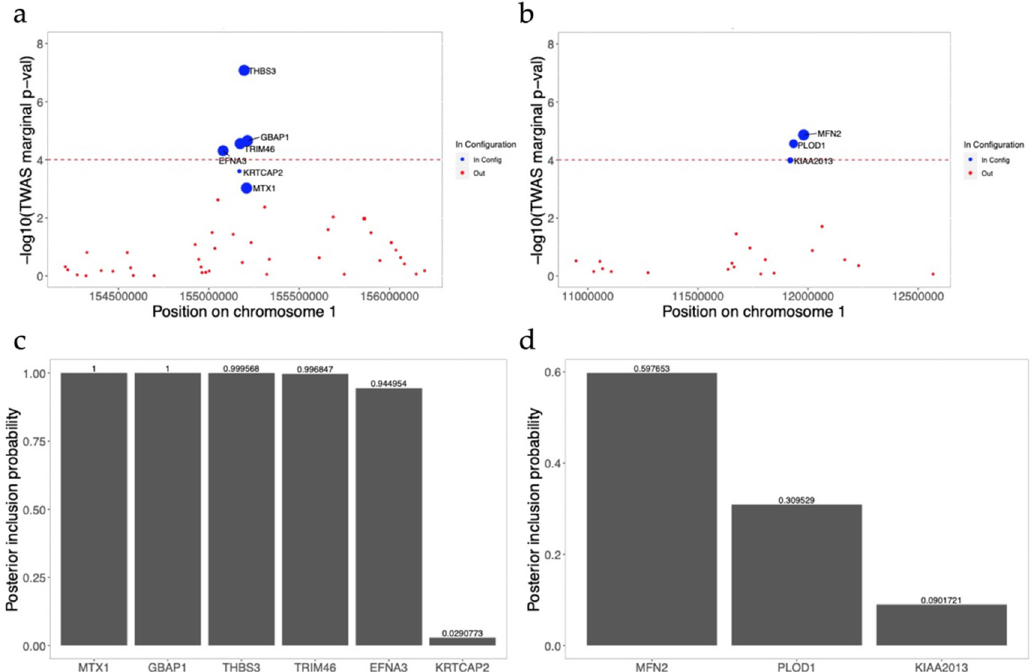
Figure 8. Fine-mapping of the THBS3 and MFN2 locus. Blue dots denote genes in the causal gene set configuration; red dots denote the genes outside of the causal gene set configuration. Dot size is proportional to the marginal posterior inclusion probability of each gene in the 95% credible set within the locus. The red dashed line denotes the TWAS significance threshold value. ( a , c ) THBS3 locus for hematocrit using Depression Genes and Networks (DGN) reference panel in African ancestry (AA) and the posterior inclusion probability of each gene in the 95% credible set within this locus; ( b , d ) MFN2 locus for platelet count using Depression Genes and Networks (DGN) reference panel in African ancestry (AA) and the posterior inclusion probability of each gene in the 95% credible set within this locus.